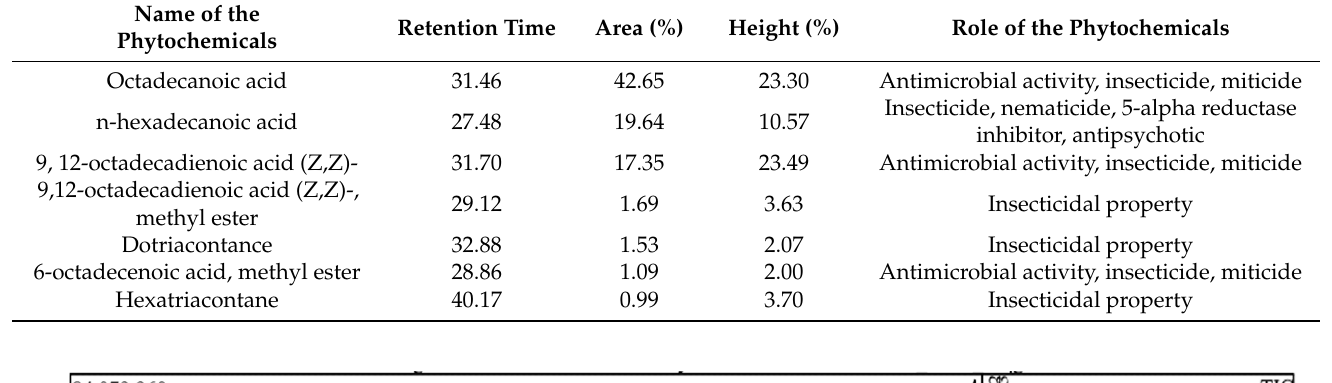
Table 1. Phytochemical constituents of bitter apple ( C. colocynthis ) seeds with insecticidal properties for insect pest management.